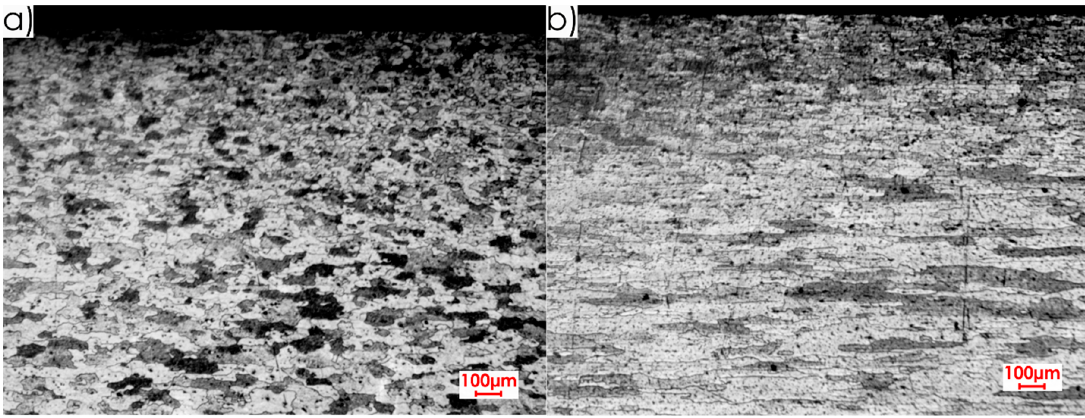
Figure 3. Microstructure of surface layer for EN AW-2017A T451 alloy: ( a ) perpendicular rolling direction, ( b ) parallel rolling direction (2.5× magnification).